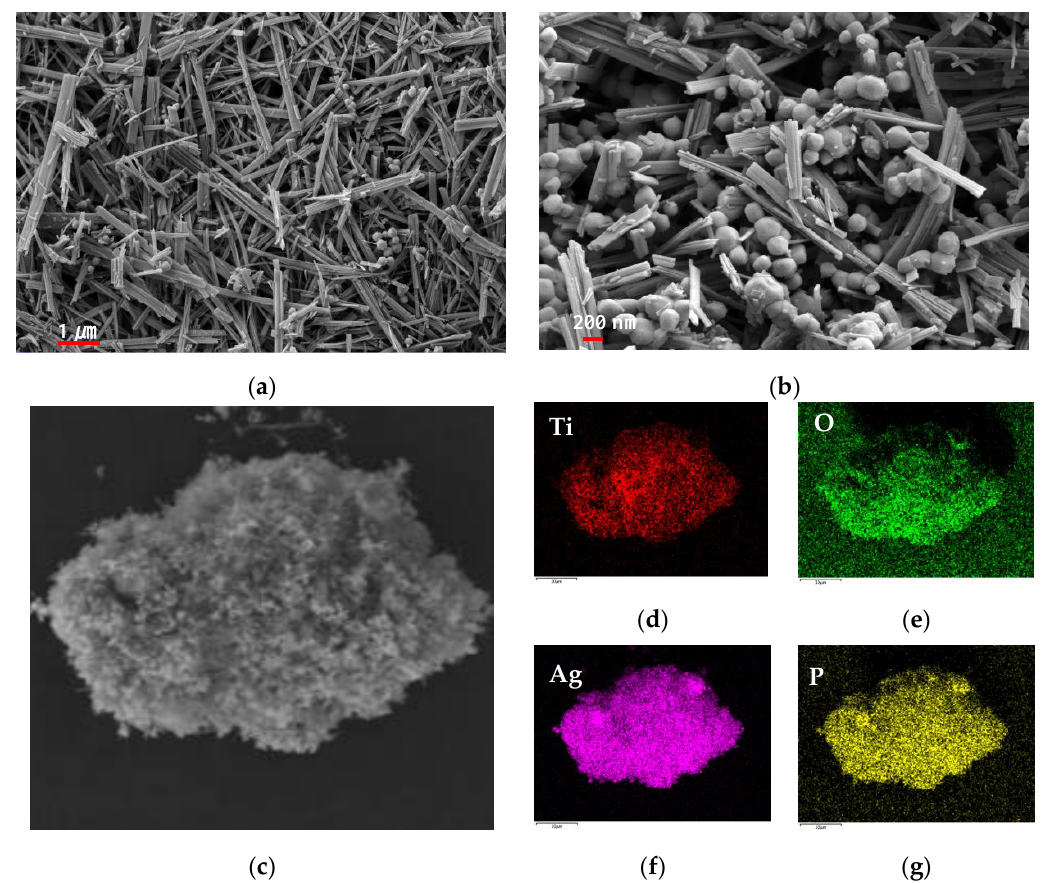
Figure 4. ( a , b ) SEM images of Ag 3 PO 4 /TiO 2 (B) composite; ( c ) The SEM image corresponding to map; ( d ) Map of Ti; ( e ) Map of O; ( f ) Map of Ag; ( g ) Map of